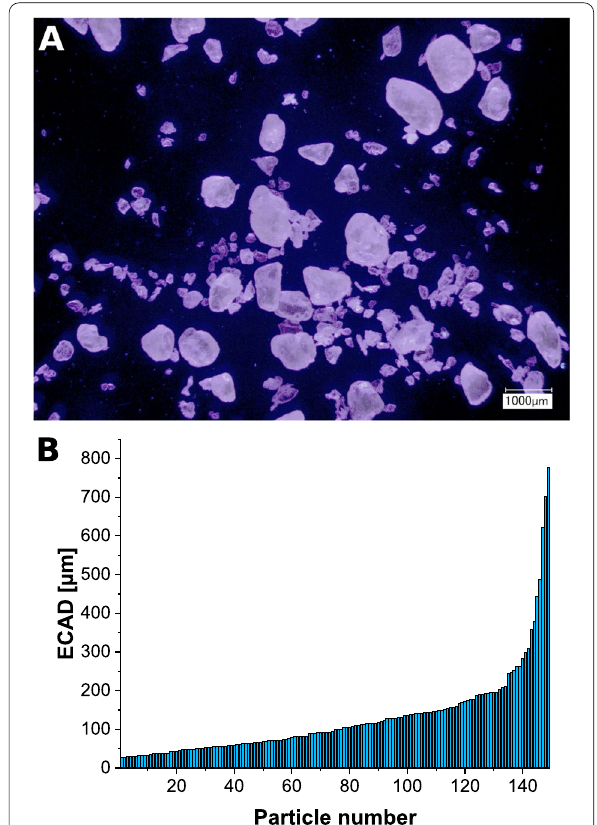
Fig. 1 Shape and size distribution of microplastic particles used in the exposure experiments. (A) Microscopic image of fluorescent polymethylmethacrylate (PMMA) particles. (B) Accumulative histogram of the equivalent circular area diameter (ECAD) of all PMMA particles detected in 10 pellets of the experimental